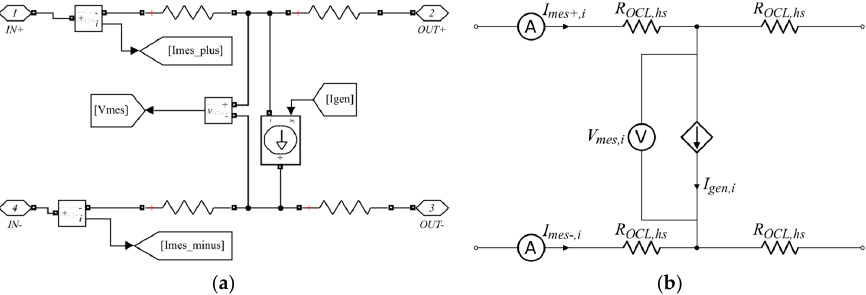
Figure 6. “H” configuration of the OCL span model, showing the Simulink representation ( a ) and circuit schematic drawing ( b ).